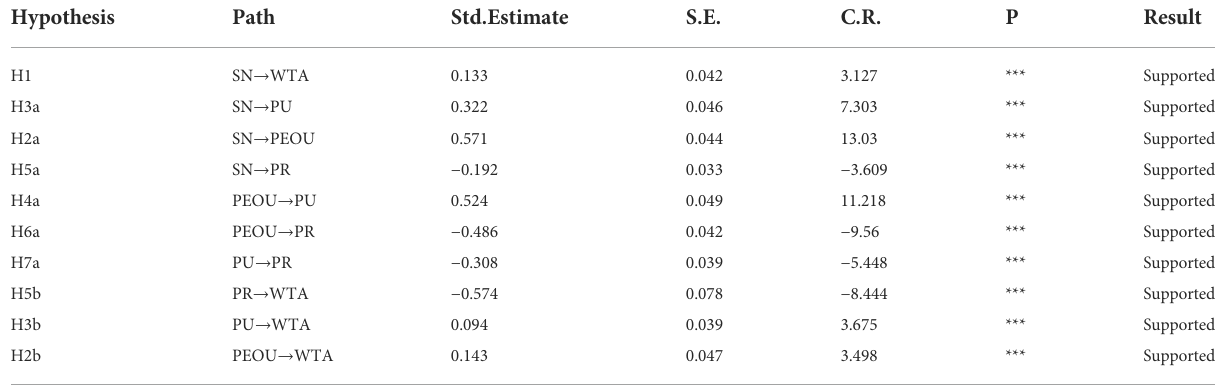
TABLE 5 Results of structural equation model analysis.